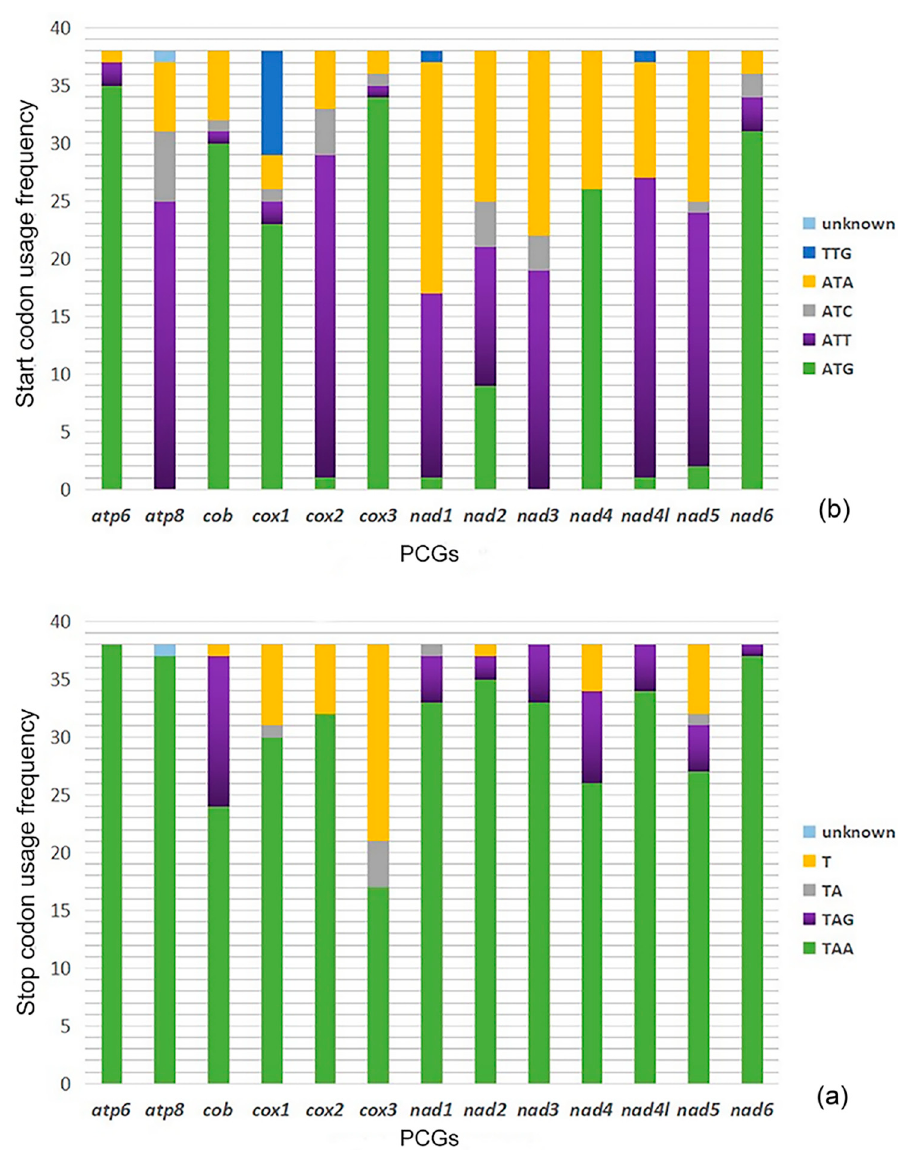
Figure 2. The use of start and stop codons in the mitochondrial genome PCGs of 38 vespids. ( a ) stop codon usage frequency; ( b ) start codon usage frequency. Note: “unknown” stands for the atp8 gene missing from the Vespidae sp. MT